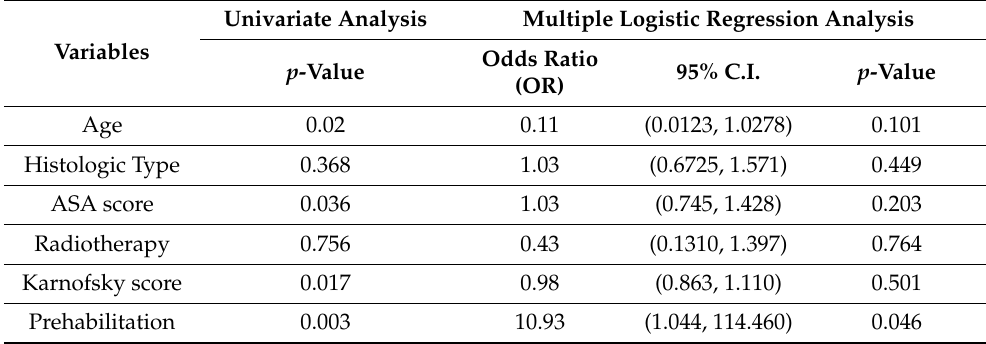
Table 3. Statistical analysis of variables associated with completion of